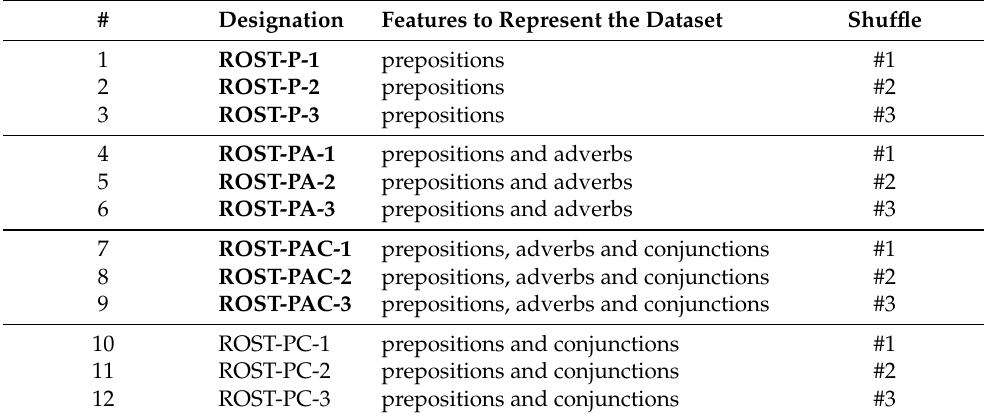
Table 10. Names used in the rest of the paper refer to the different dataset representations and their shuffles. Only the first 9 entries (with the Designation written in bold) were used for the entire set of